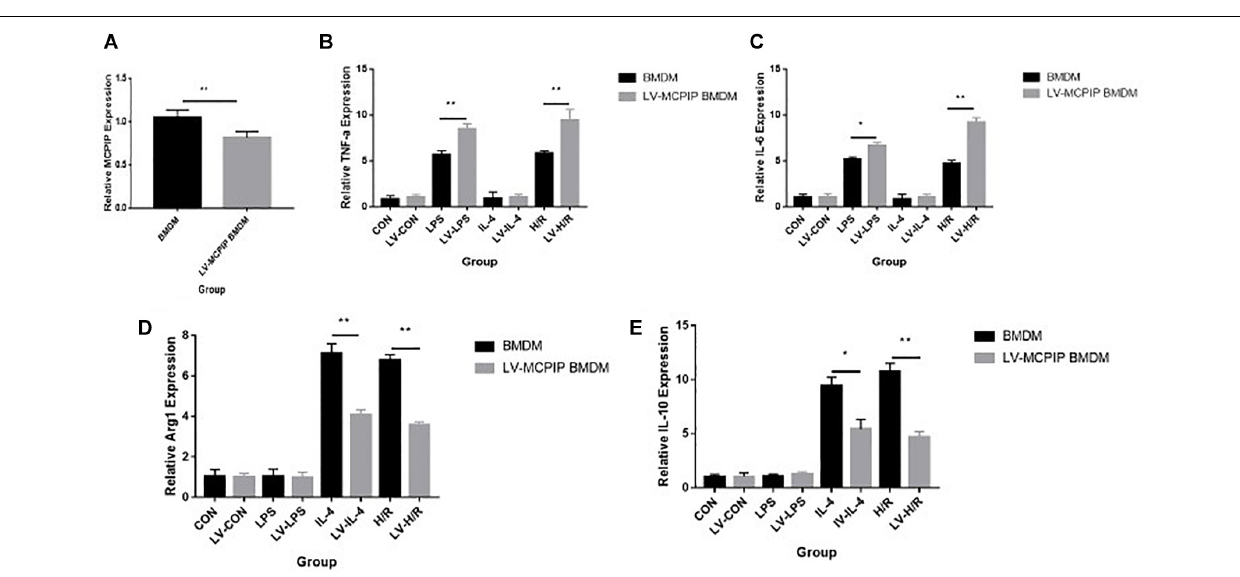
FIGURE 5 | Gene expression levels of MCPIP and M1 (TNF-a and IL-6) and M2 (IL-10 and Arg1) markers in BMDM with or without MCPIP deficiency were measured by RT-PCR. * P < 0.05 and ** P < 0.01. BMDM, bone marrow derived macrophage; LV-MCPIP BMDM, bone marrow derived macrophage with regnase-1 knockdown by lentiviral